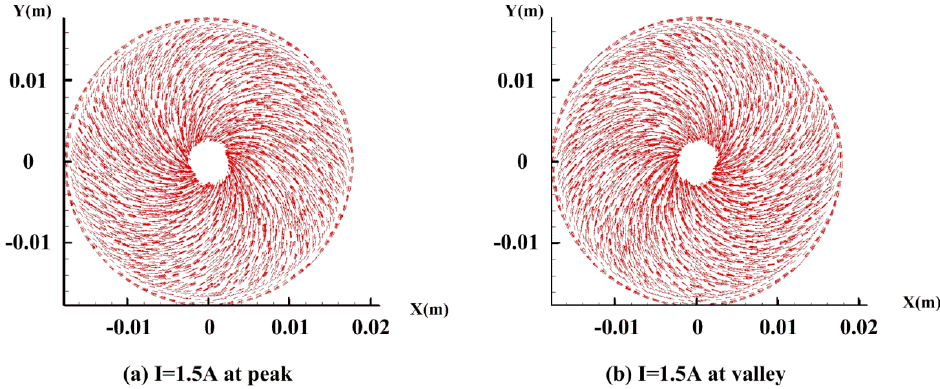
Figure 10. The vector graphs of velocity on the middle plane z = − 0.001 m with the energized current I = 1.5 A at the peak and valley when rotating with Ω = sin(2 π · 0.01 · t).